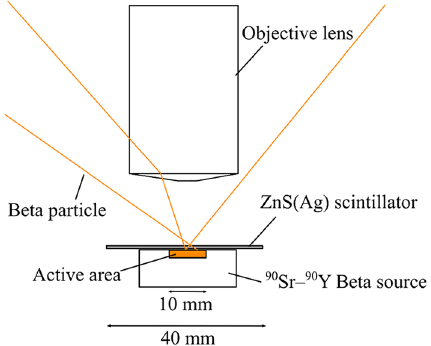
Figure 11. Schematic drawing of the beta source imaging.